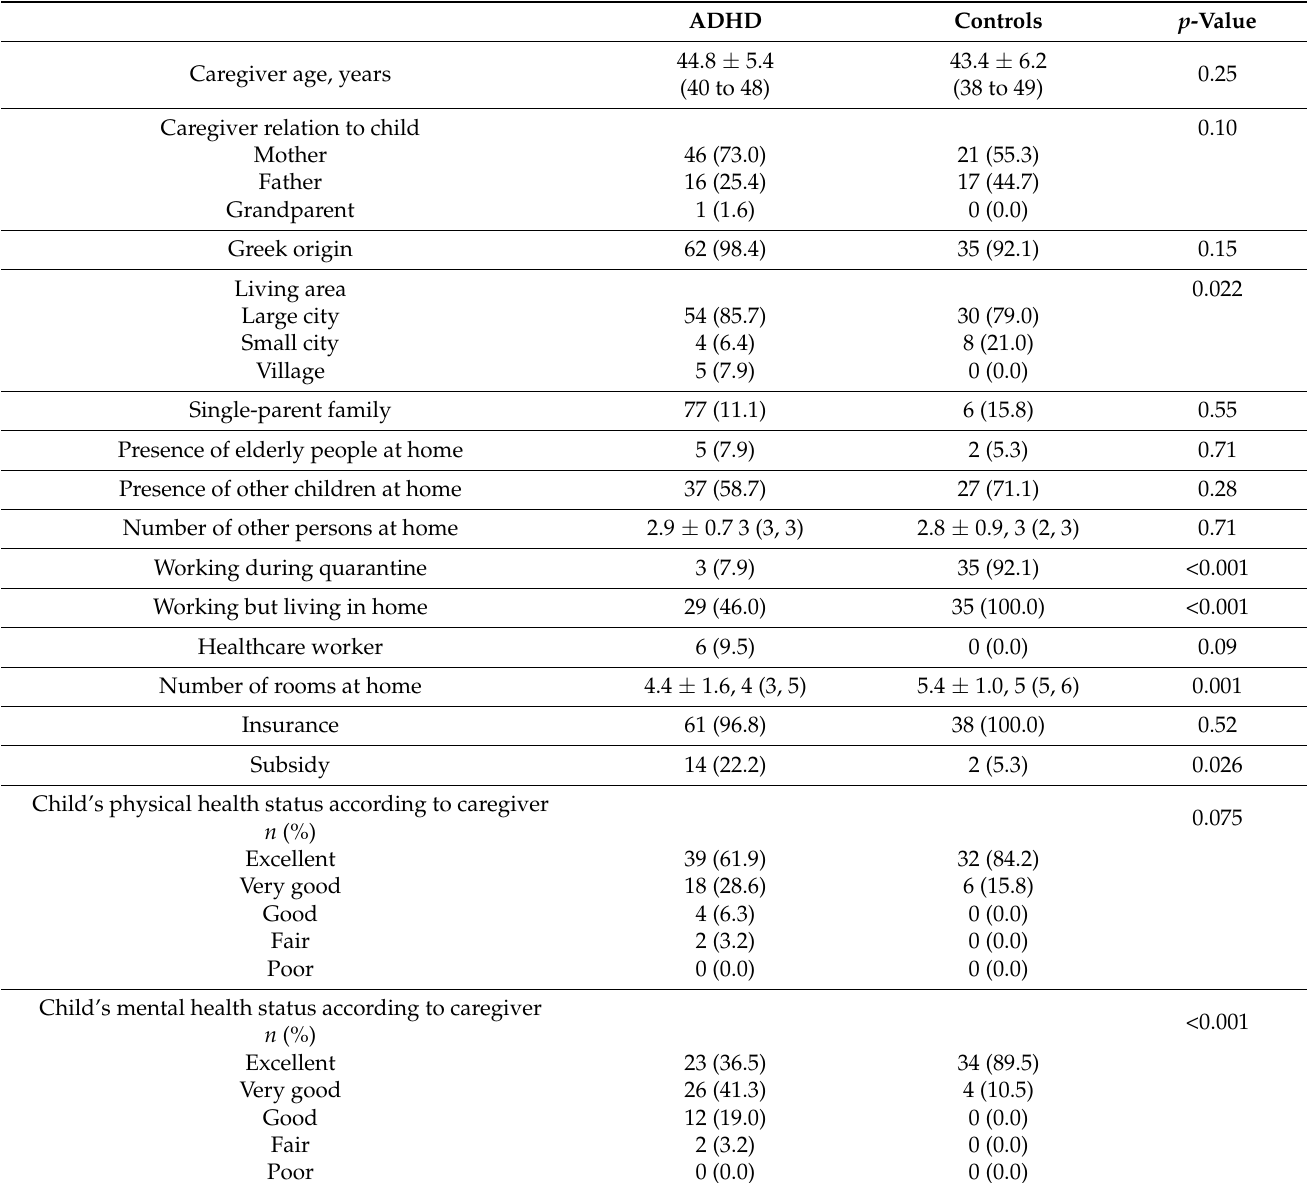
Table 1. Demographic, socioeconomic and health-related data in the study